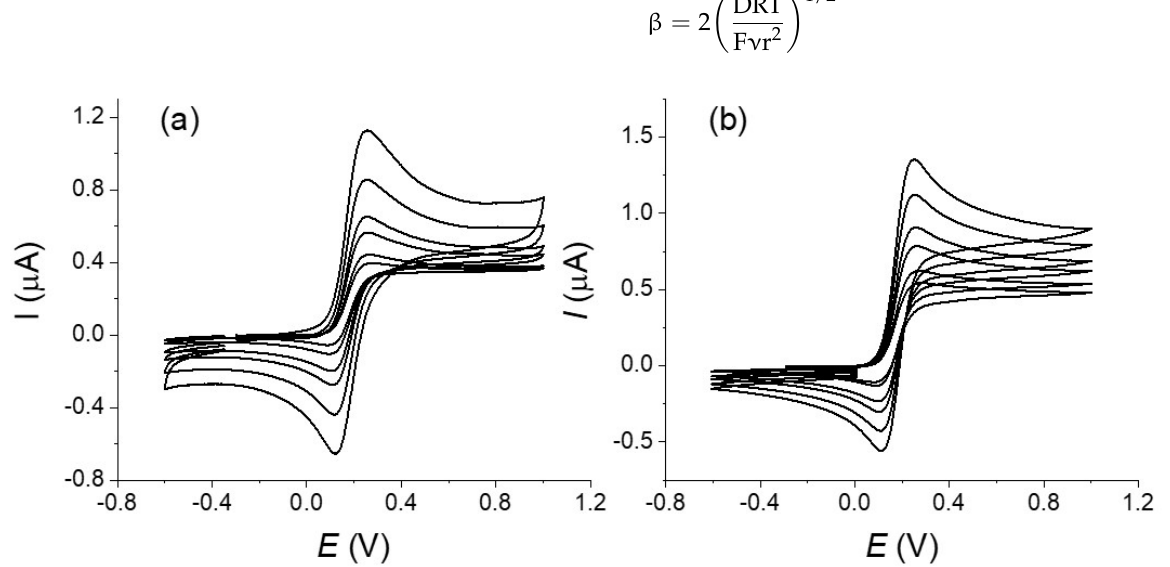
Figure 2. Voltammograms of a 5 × 10 −3 mol L −1 of a 1,1′-dimethanolferrocene solution in H 2 SO 4 0.1 mol L −1 and KCl 0.5 mol L −1 (WE: carbon fiber; CE: platinum wire; RE: Ag/AgCl 3M) at different scan rate: 10, 25, 100, 200, 500 and 1000 mV s −1 . ( a ) Crude fiber (type 1), ( b ) after strong oxidation treatment (type 3).